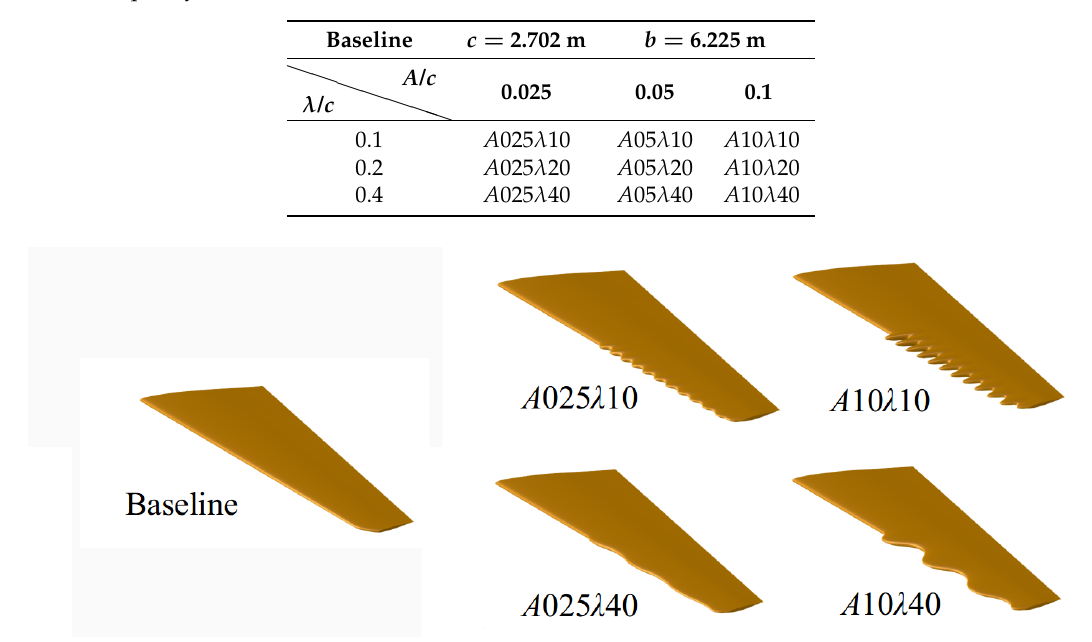
Table 5. Configurations of leading-edge tubercles with leading edge tubercles of varying amplitude and frequency.